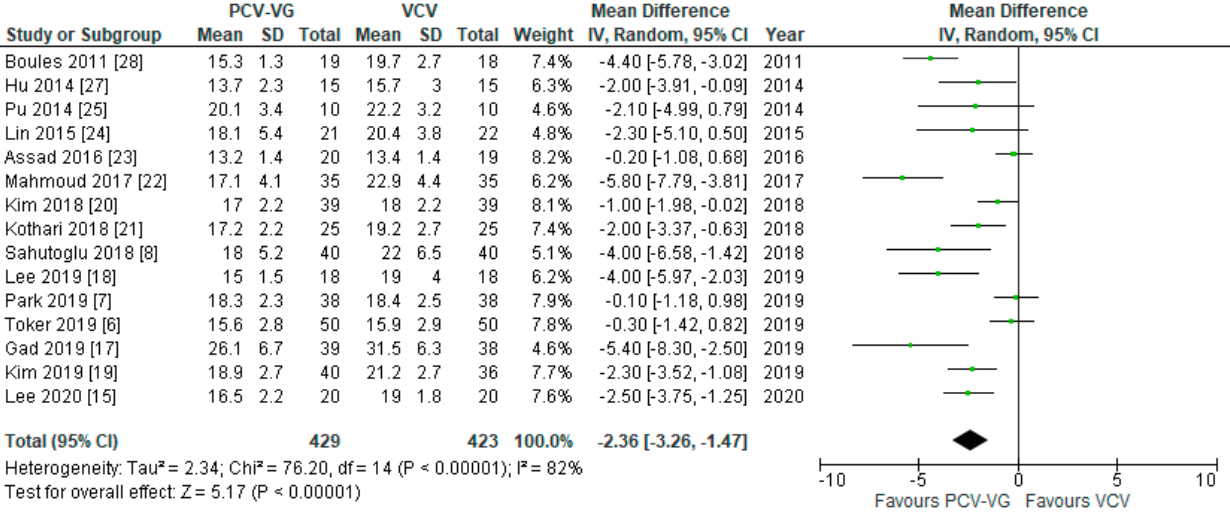
Figure 4. Peak airway pressure (P peak ): supine, two-lung ventilation. The green center of each square represents the weighted mean difference for individual trials, and the corresponding horizontal line stands for a 95% confidence interval. J. Clin. Med. 2021 , 10 , x FOR PEER REVIEW The diamonds represent pooled results.